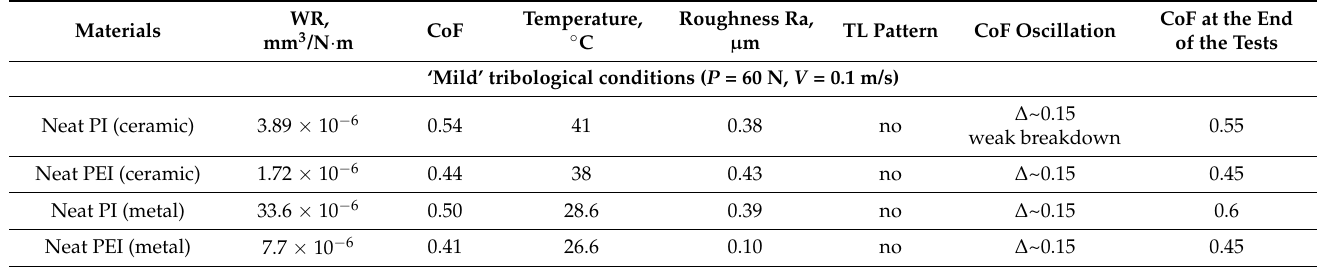
Table 5. A comparison of the tribological properties and the TL characters for neat PI and PEI.